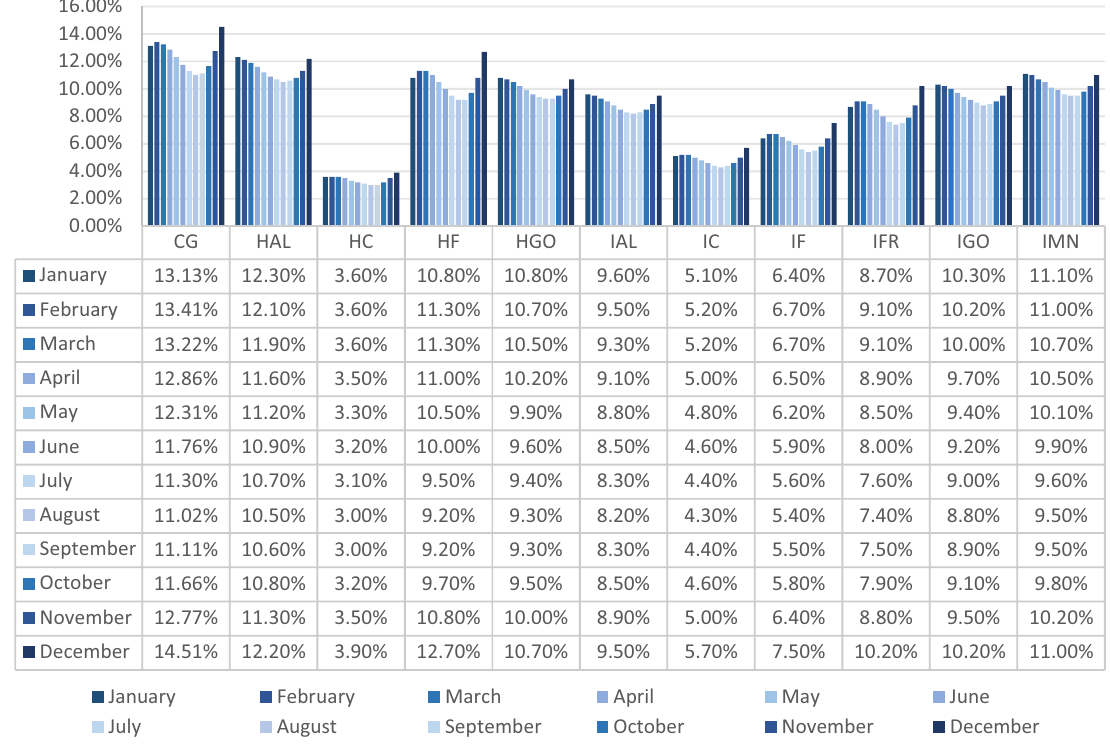
ganiferous itabirite (IMN), high-grade soft itabirite (IFR), soft hema- tite (HF), compact hematite (HC), goethite–hematite (HGO), alumi- nous hematite (HAL) and canga